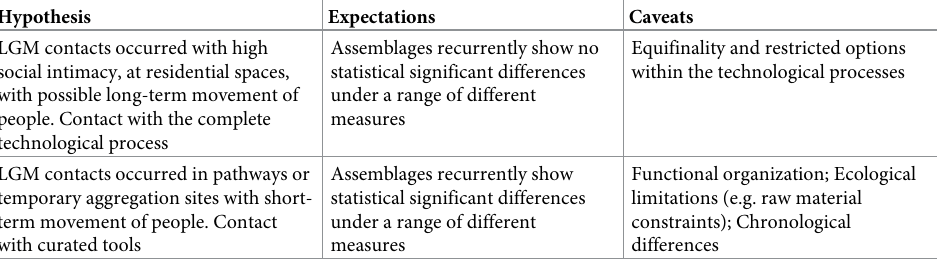
Assemblages recurrently show no statistical significant differences under a range of different measures Assemblages recurrently show statistical significant differences under a range of different measures